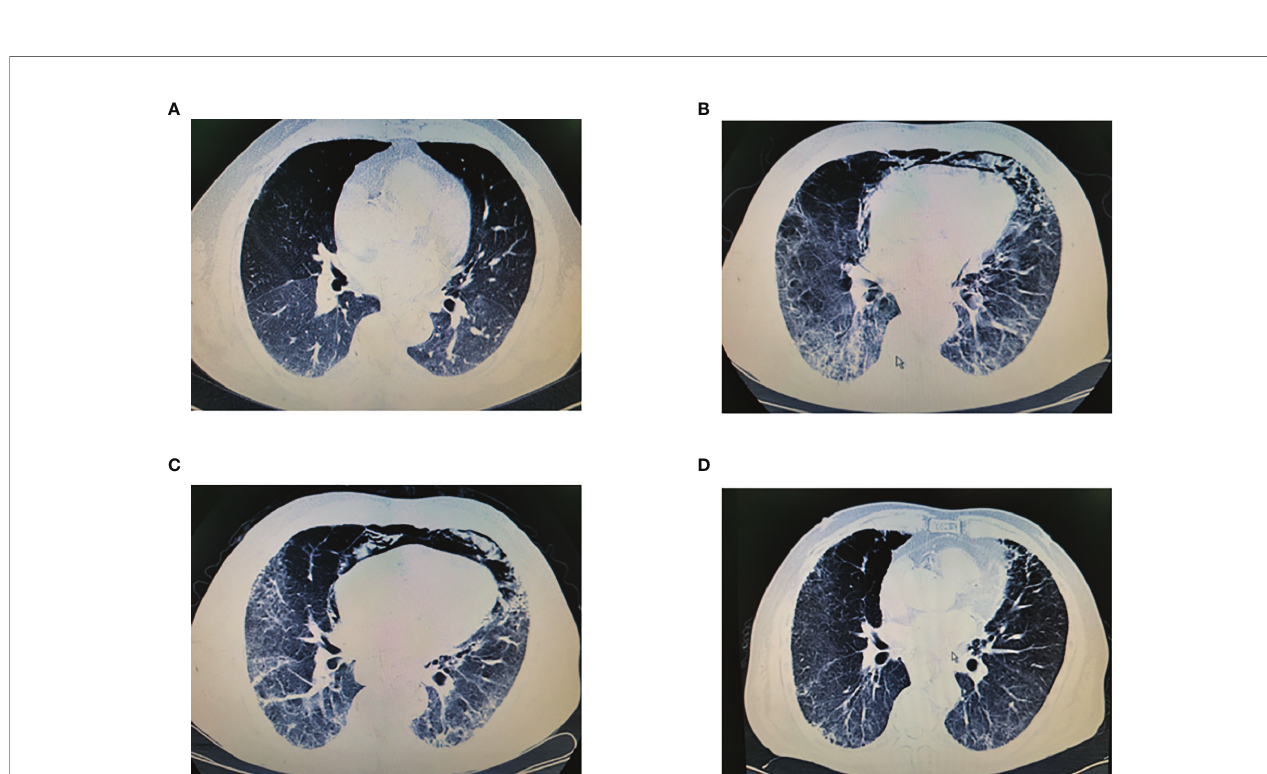
FIGURE 3 | (A) Chest CT scan before surgery. (B) Chest scan on 5th day after operation. (C) Chest scan after application of methylprednisolone for 7 days. (D) Chest scan in 3 months after discharge.